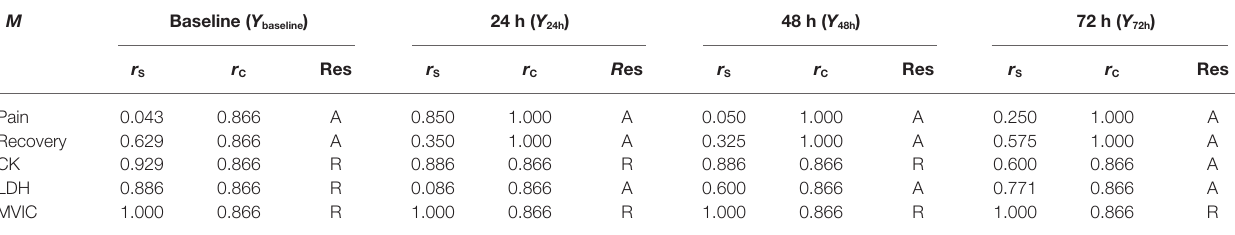
All the coefficients are calculated in relation to the postfight, considered as an independent variable (X) in this analysis. The other observables are considered dependent (Y). The values used in the calculations were extracted from Tables 3, 4 for the set of parathletes I, II, III, IV, V, and VI. The null hypothesis is rejected when p is less than 0.05, which corresponds to the inequality r S > r C . M, marker; r C , critical coefficient; Res, result; A, accepted; R, rejected.